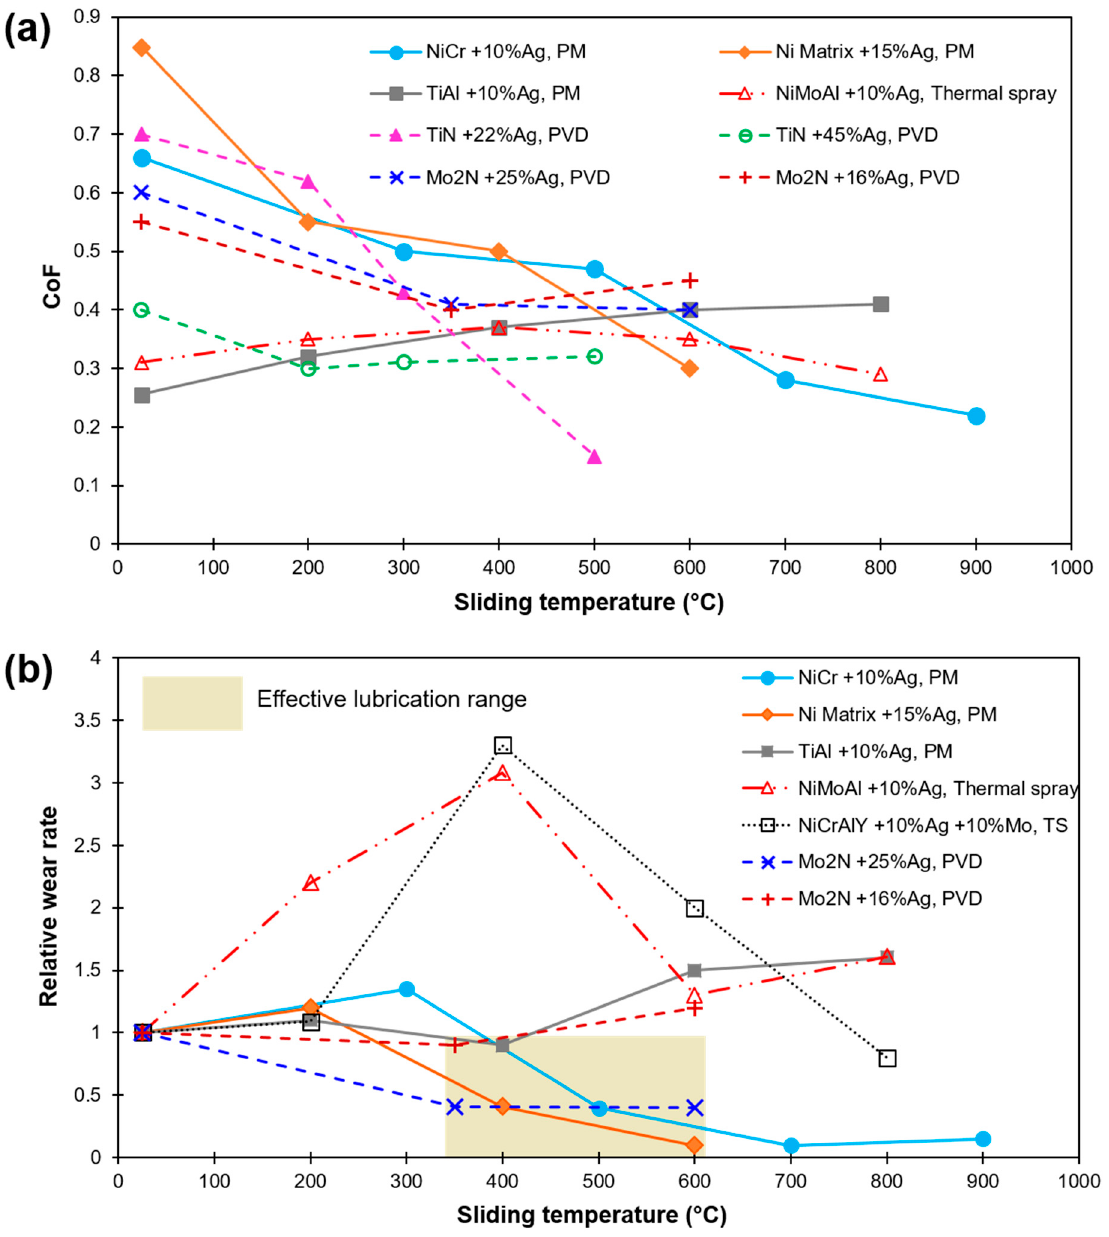
Figure 4. HT sliding results of Ag-based composites and coatings as found in recent literature ( a ) CoF; ( b ) Relative wear rate (in relation to their corresponding RT wear). Values are labeled as per Ag concentration, matrix material, and fabrication method [10, 13–21].